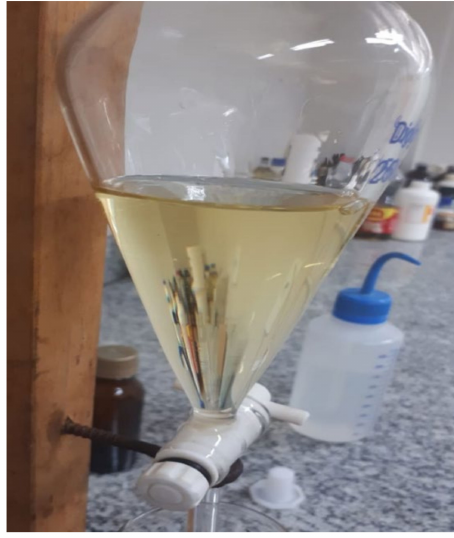
Figure 3. Biodiesel obtained from